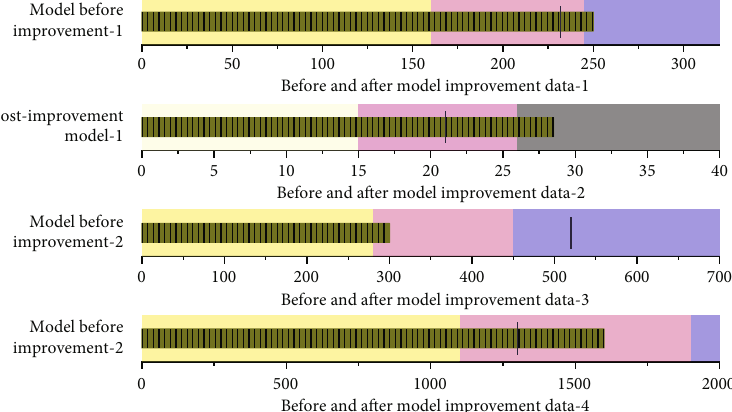
Figure 7: Comparison of the e ff ect duration ratio of the improved